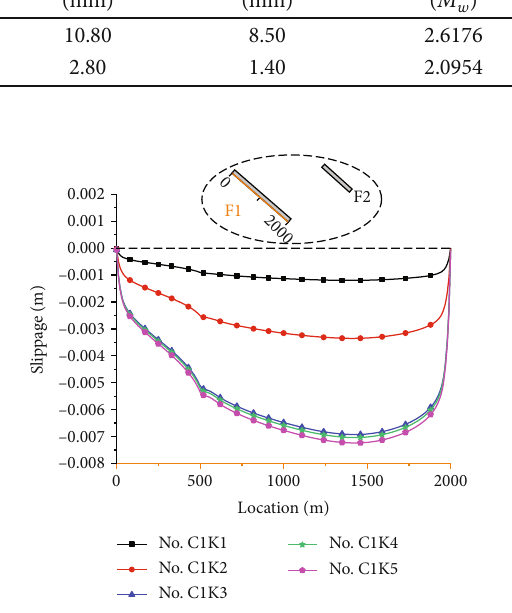
Table 5: The induced slippage and moment magnitude of faults F1 and F2 under di ff erent fracturing patterns. Experiment No.